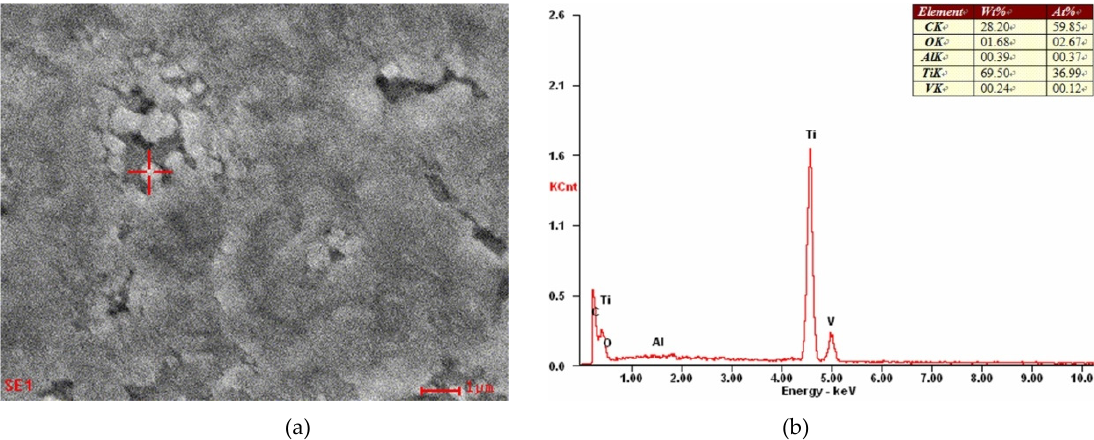
Figure 3. Micromorphology and EDS analysis of surface of titanium alloy after heated in argon. (a) Micromorphology; (b) EDS analysis.